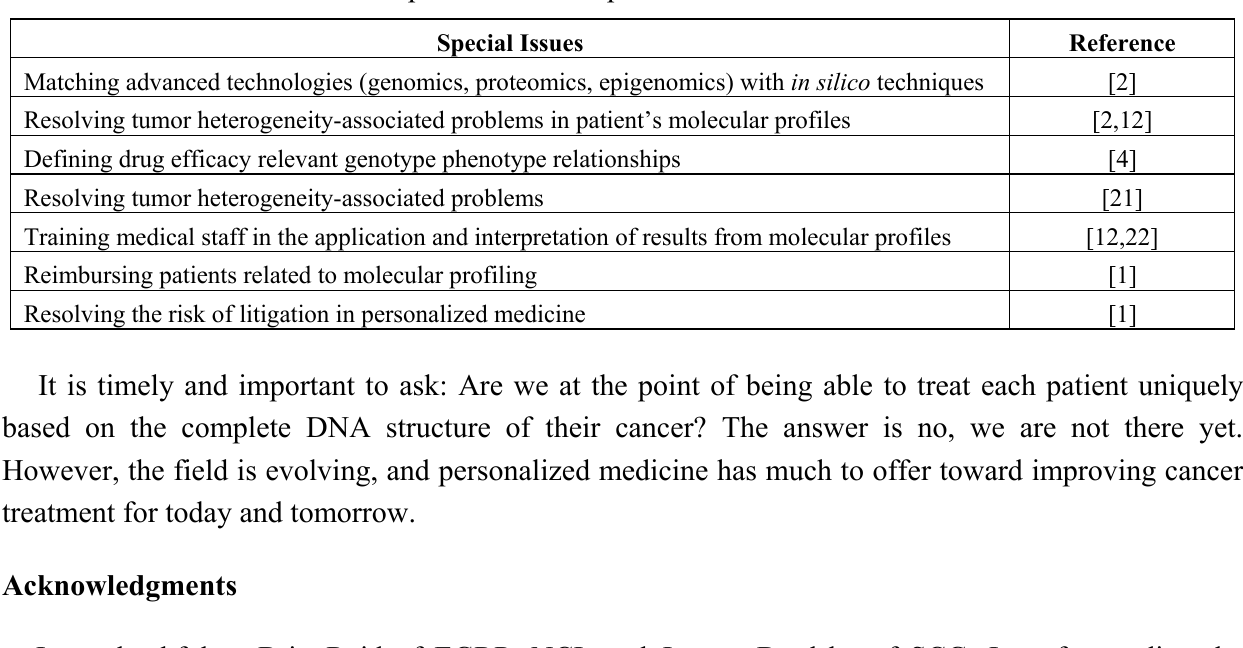
Table 1. Specific issues in personalized medicine and